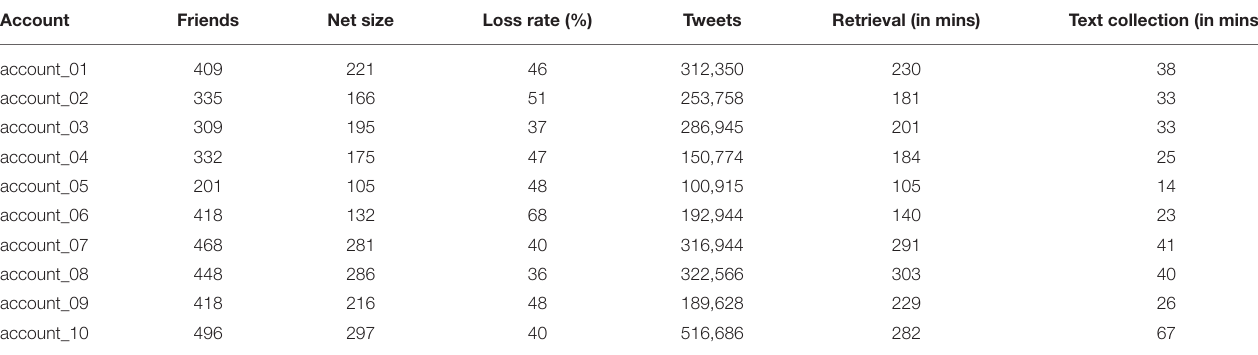
TABLE 1 | Raw statistics for the data used in section An Algorithmic Approach to Networks in